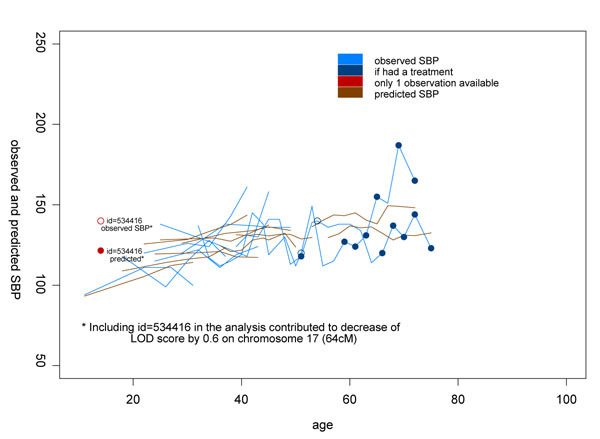
Observed and predicted SBP profiles for pedigree 32,445 members